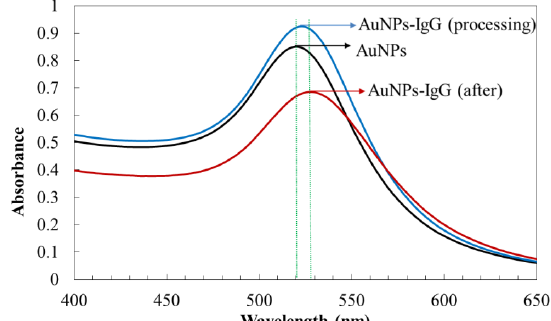
Figure 3. The UV-Vis absorption spectra comparison of gold nanoparticles and AuNPs-IgG complex particles.